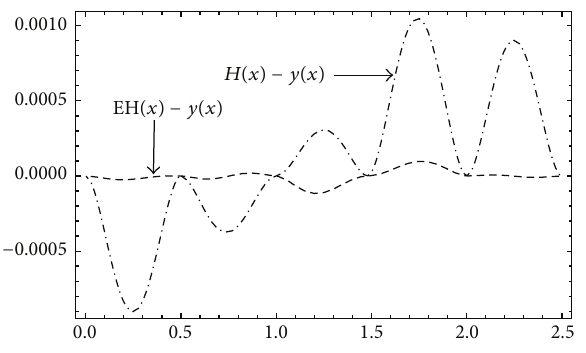
Figure 3: The error curves of the EH (𝑥) − 𝑦(𝑥) and 𝐻(𝑥) − 𝑦(𝑥) .